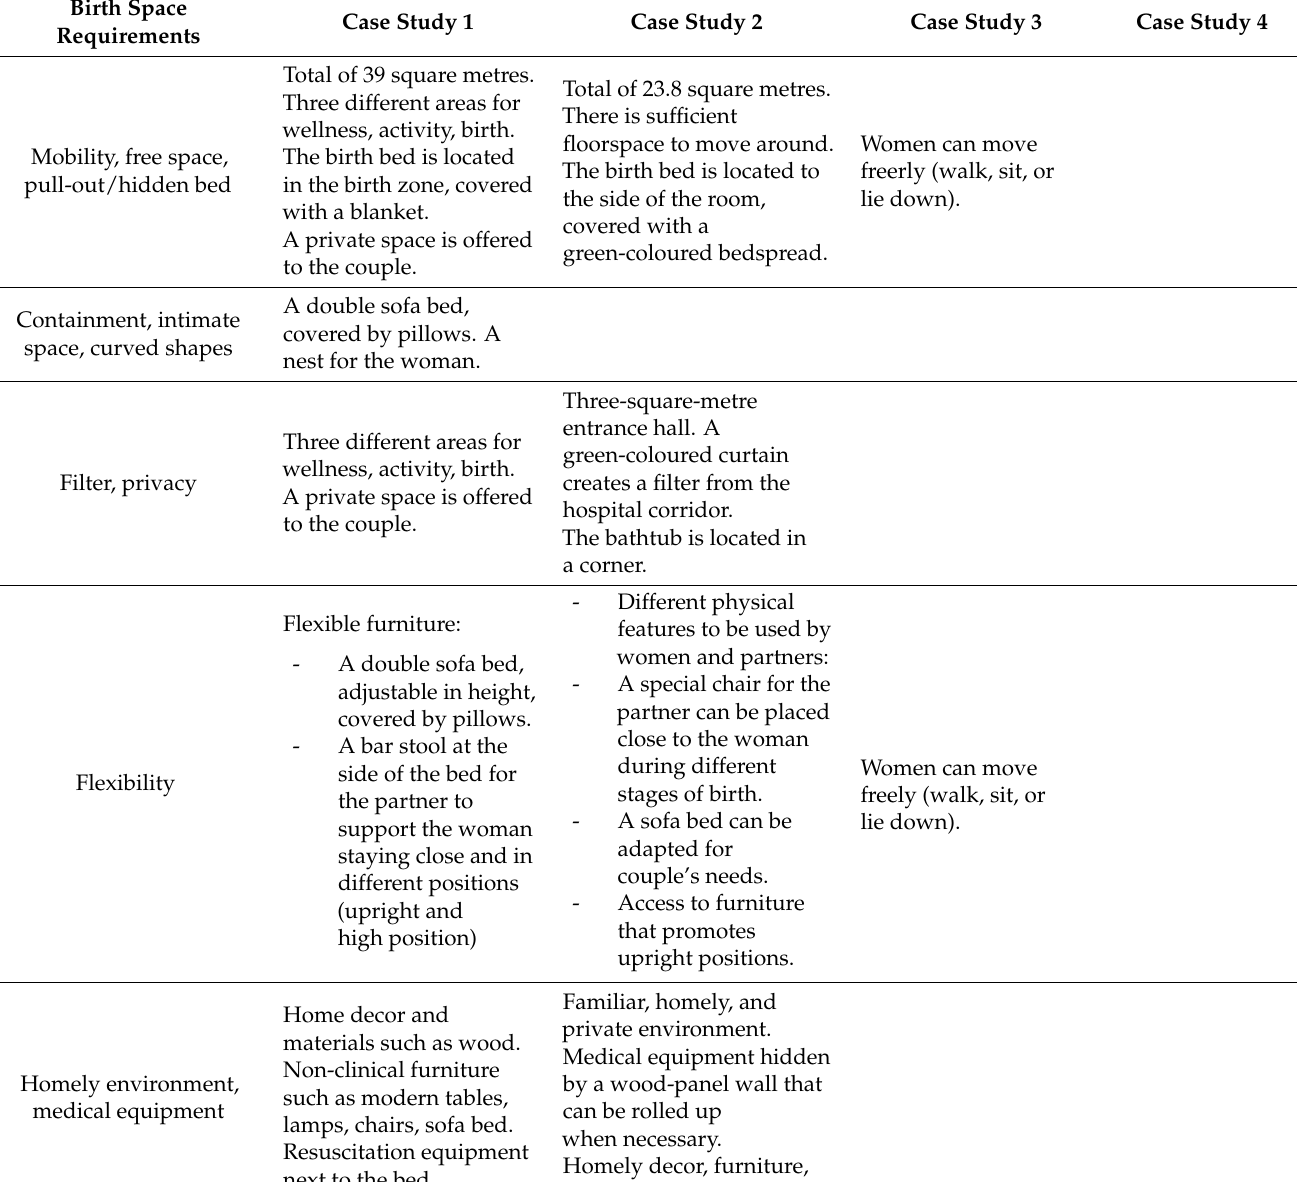
Table 2. Birth space requirements: solutions